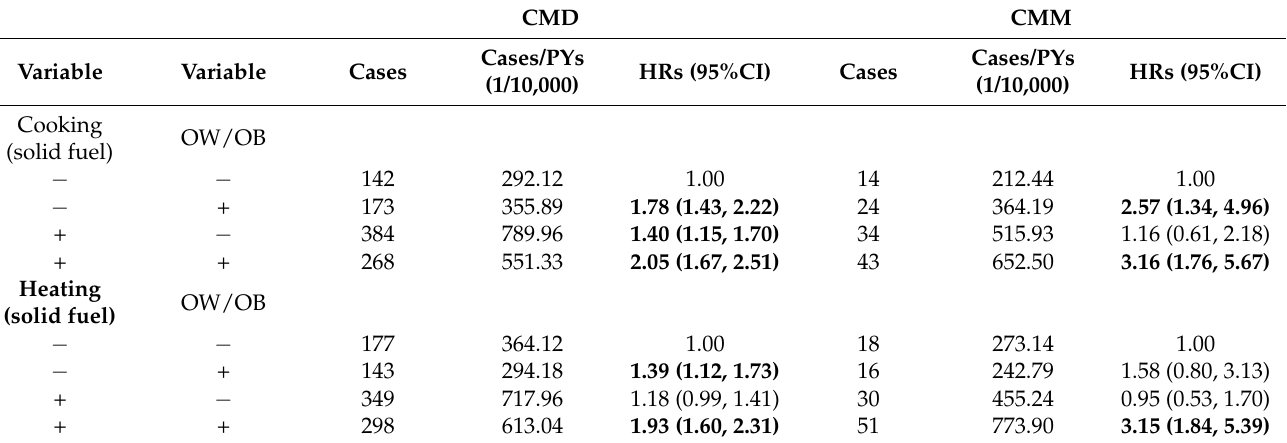
Table 4. Interactions between household solid fuel exposure and OW/OB on the incident of CMD and CMM. CMD